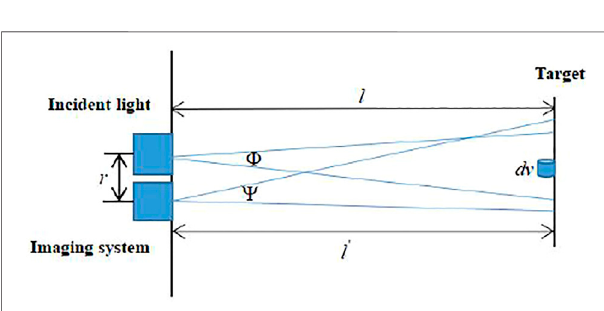
FIGURE 2 | The schematic diagram of backward scattering to underwater